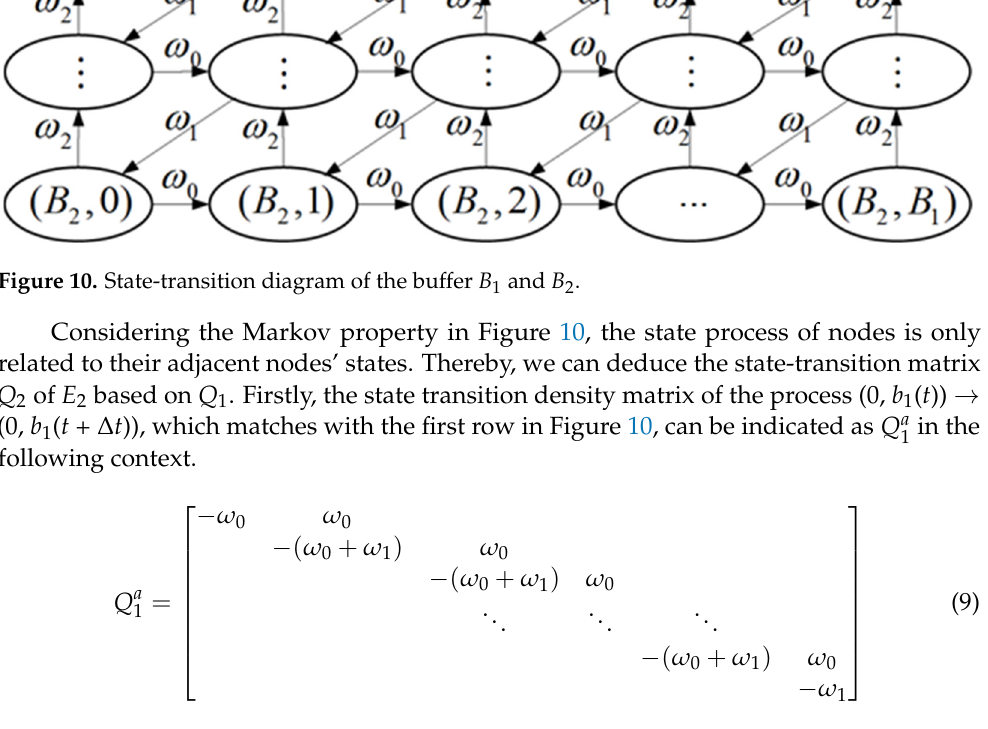
= 0, 1, 2, …, B 2 , b 1 ( t ) = 0, 1, 2, …, B 1 ; the state-transition process of both buffer B 1 and B 2 is shown in Figure 10.